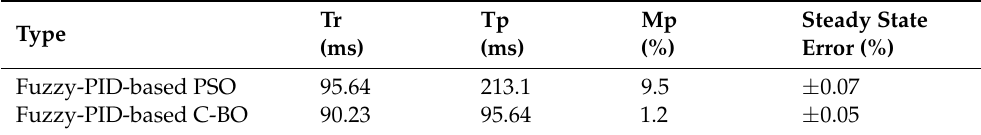
Figure 30. Experimental motor speed under ( a ) fuzzy PID based PSO and ( b ) C-BO-based fuzzy PID. Table 9. Speed-controller performance at proposed loading.